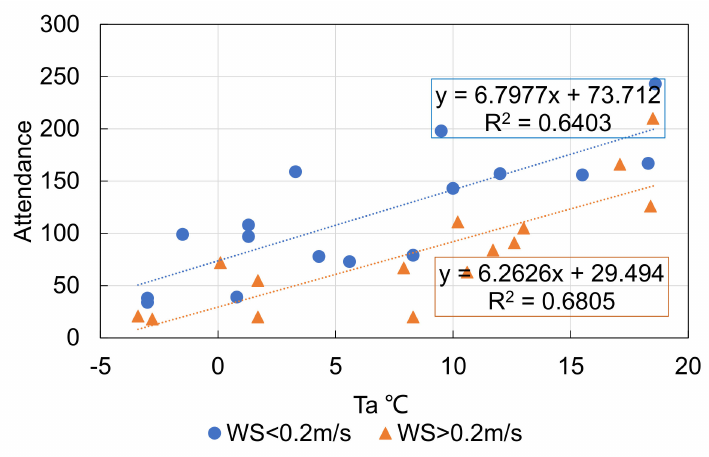
Figure 8. Wind speed’s influence on attendance of optional activities when T a < 20 ◦ C.